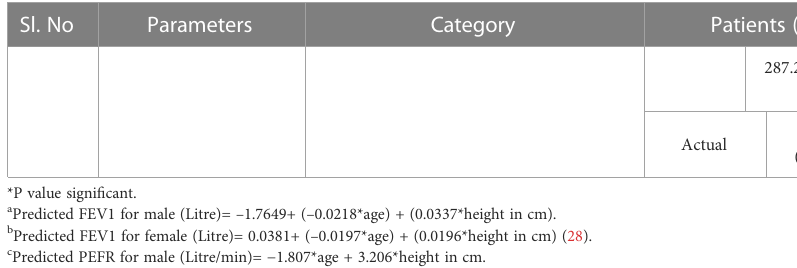
Figure 4. One-way ANOVA test revealed that signi fi cant difference existed in FEV1/FVC ratio of both male and female patients residing in different habitats (Urban, semi-urban and rural) (F=40.63 and P<0.0001 and F=24.28 and P<0.0001 respectively); while that in control males and females, it remained non-signi fi cant (F=0.21 and P=0.81 and F=0.31 and P=0.73 respectively). Urban patients showed the lowest FEV1/FVC value than others.